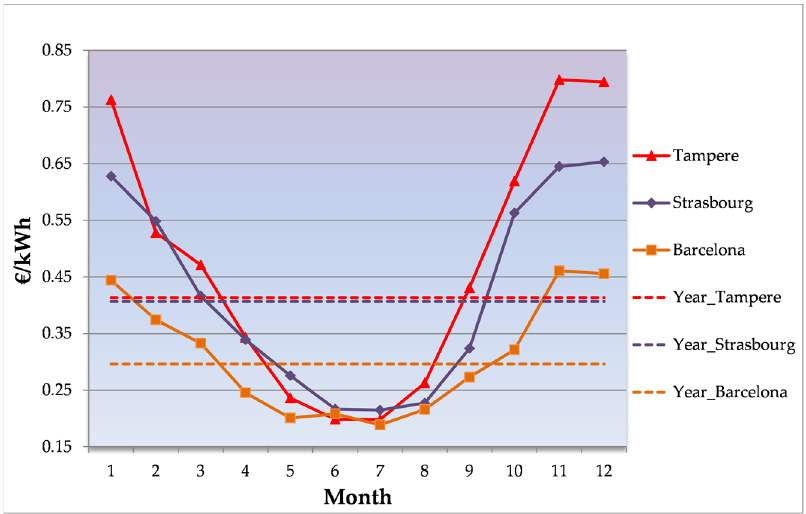
Figure 5. The exergo-economic cost of electricity on monthly and annual basis in different locations adapted from [9].